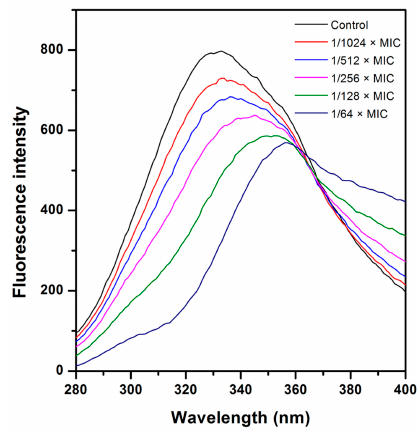
Figure 5. Effect of CHQA on fluorescence intensity of the S. aureus ATCC 6538 membrane protein at λ ex 258 nm.